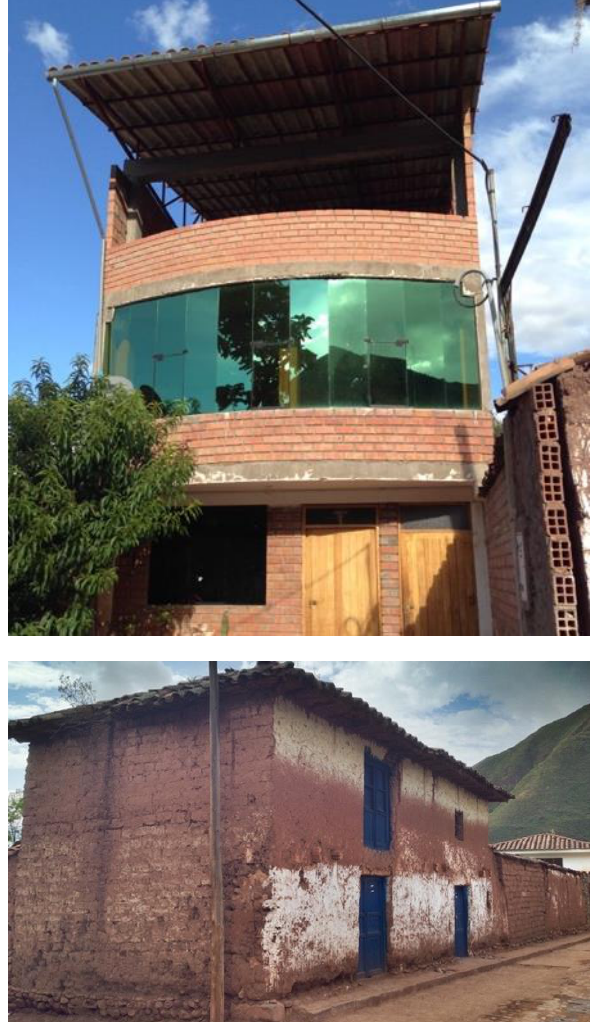
Figure 4. Houses in Cusco,